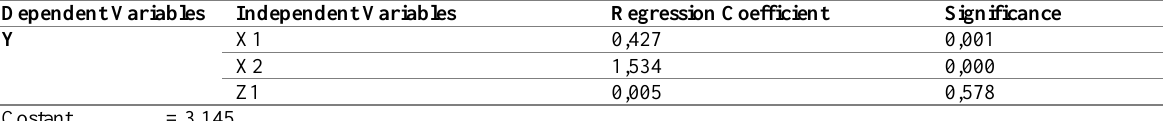
Table 4: Moderation Regression Recapitulation